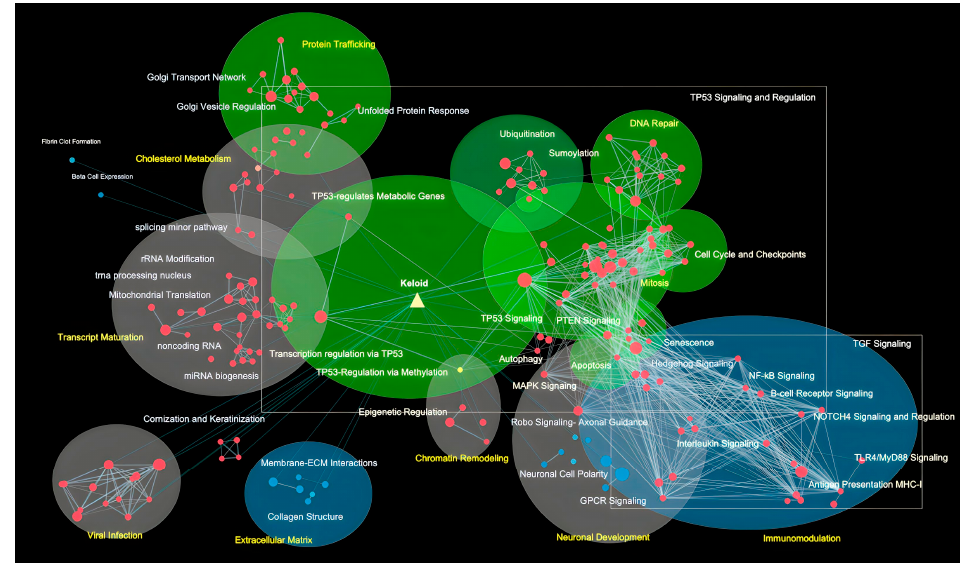
Figure 3. Gene ontology hallmark landscape of keloid . In the layout, we depicted the TP53-associated pathway (Green), Wnt/ β -catenin signaling (blue), and miscellaneous (grey) with different colors and highlighted their complex interactions. Nodes depicted in red signify increased enrichment and those in blue signify decreased enrichment.